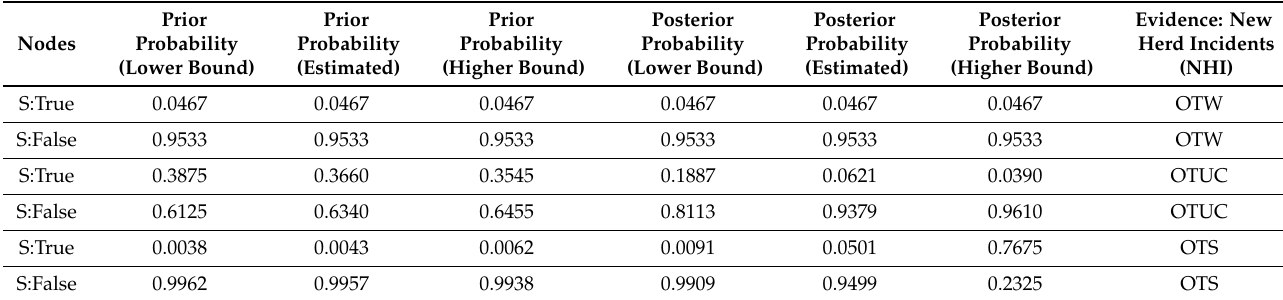
Table 7. Prior and posterior probabilities for node S in high-risk areas of England cattle farms.